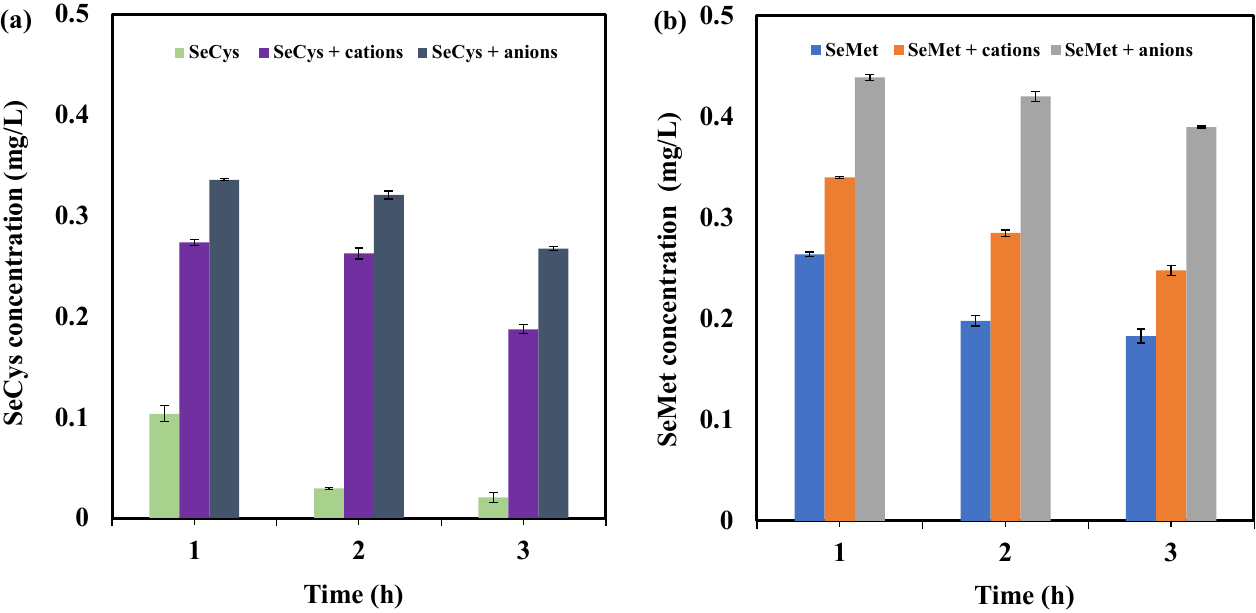
Figure 11. Comparative study on the influence of cations (competing together) and anions (competing together) on organoselenium removal by nZVI/GAC. ( a ) SeCys, ( b ) SeMet; initial concentration of 0.5 mg/L, 3 g/L, pH 7.0 at 25 °C. Contact time is 3 h; ion concentration is 100 mg/L.